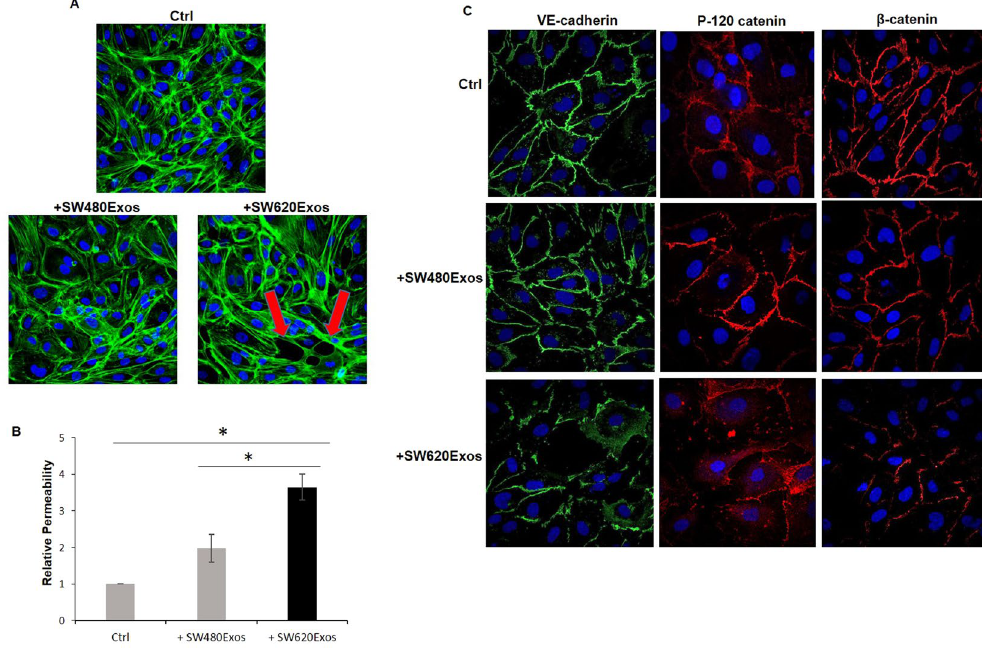
Figure 5. Exosomes derived from cancer cells with different grade of aggressiveness differentially affect the properties of endothelial cells. ( A ) Confocal micrographs of HUVECs treated for 6 hrs with 20 μ g/ml of SW480 or SW620 cell-derived exosomes. ( B ) Dextran permeability assay of HUVEC monolayer. Permeability assay was performed by adding in the upper chamber 20 μ g/ml of SW480Exos or SW620Exos and 6 hrs after determining FITC-Dextran fluorescence in the lower chamber. Values reported in the graph are the mean ± SD of three independent experiments. Statistical significance was calculated as indicated by the horizontal lines; * p ≤ 0.05. ( C ) Confocal micrographs of HUVECs treated for 6 hrs with 20 μ g/ml of SW480Exos or SW620Exos show the localization of VE-cadherin (green), P-120 catenin (red) and β -catenin (red). Nuclear counterstaining was performed using Hoescht (blue). Ctrl (Control): HUVECs treated with